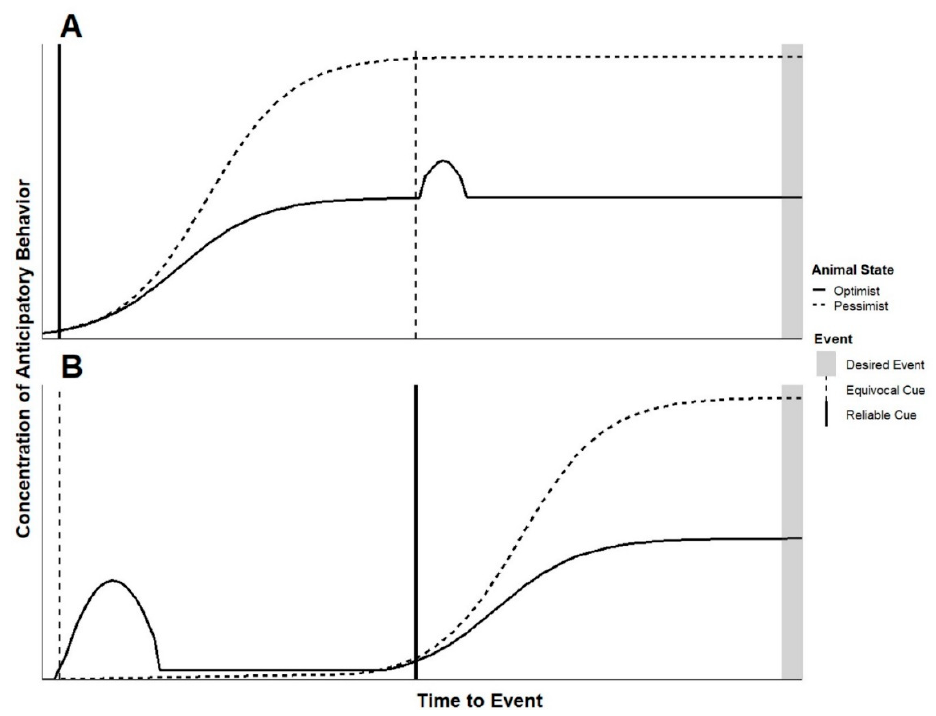
Figure 4. Predicted responses of animals in an optimistic or pessimistic state to ( A ) a reliable cue for an event followed by an equivocal cue and ( B ) an equivocal cue followed by a reliable one.